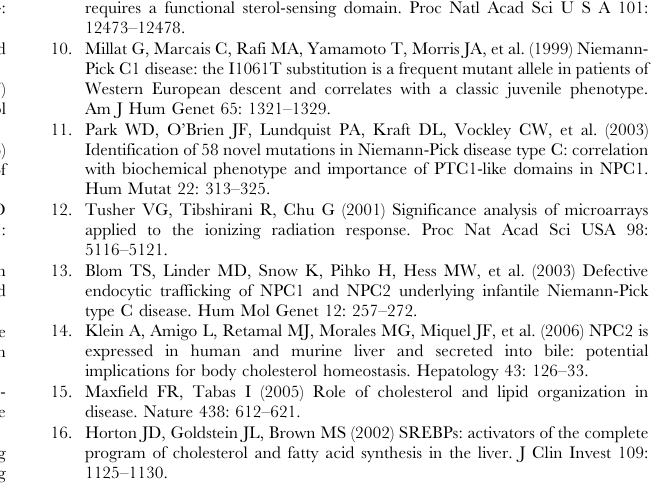
Dataset S1 This excel file presents SAM results for this data set, sorted alphabetically. False discovery rates are all ,